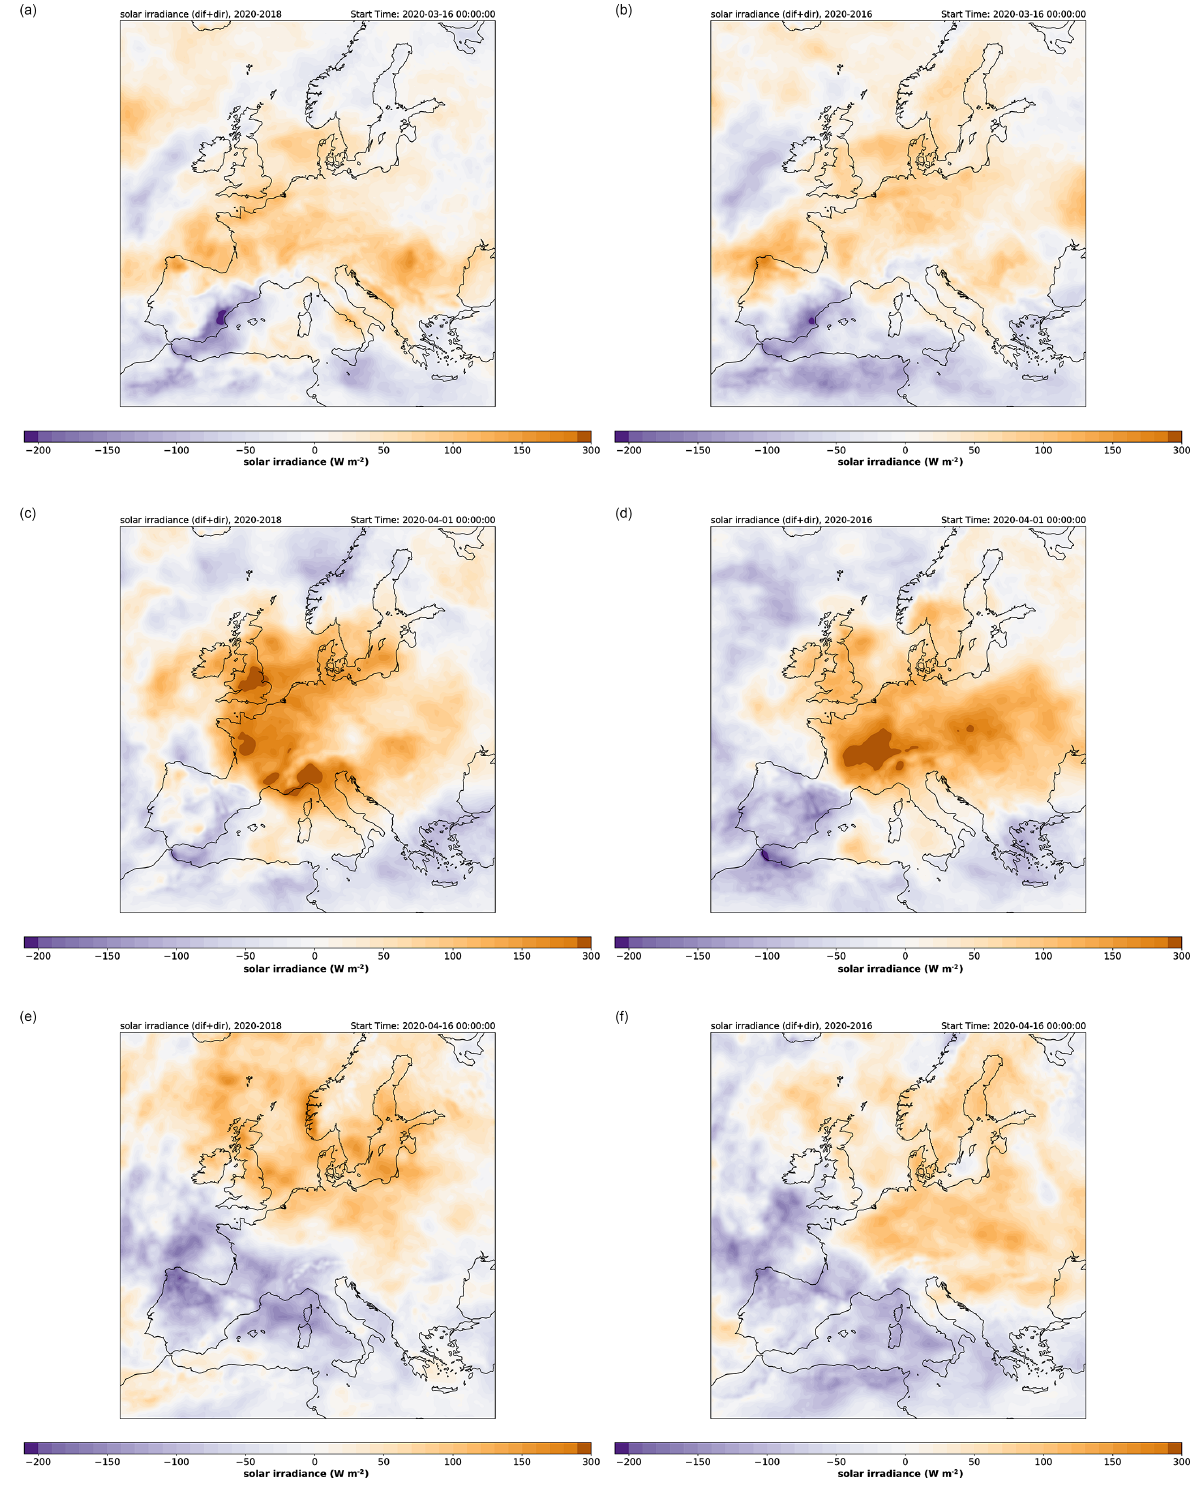
Figure A14. Solar irradiance (in Wm − 2 , colour code): differences between 2020 and 2018 (a, c, e) and between 2020 and 2016 (b, d, f) for the half-month periods 16–31 March (a, b) , 1–15 April (c, d) and 16–30 April (e, f) .